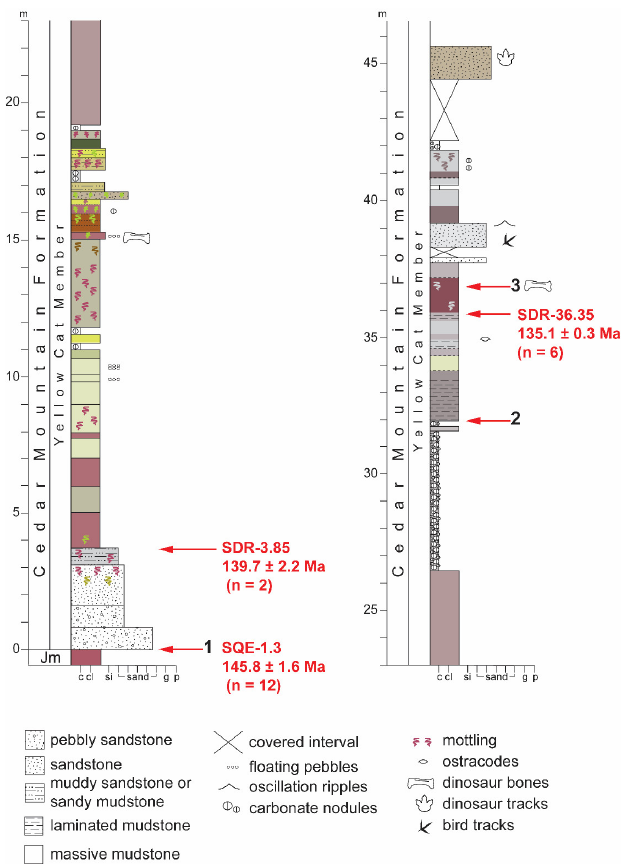
Figure 2. Stratigraphic section at Utahraptor Ridge. Important contacts in bold black numerals 1–3 are: (1) top of the Brushy Basin Member of the Jurassic Morrison Formation (Jm); (2) top of a thick and prominent “calcrete” or horizon of large to very large carbonate nodules, described by Kirkland et al. [2] (their figure 19); and (3) approximate position of Stikes Quarry, also described by Kirkland et al. [2] (their figure 19). Kirkland et al. [2] (their figure 19) placed the top of the “calcrete” at 30 m above the upper contact of the Morrison Formation, whereas it is placed at approximately 32 m in ours. This